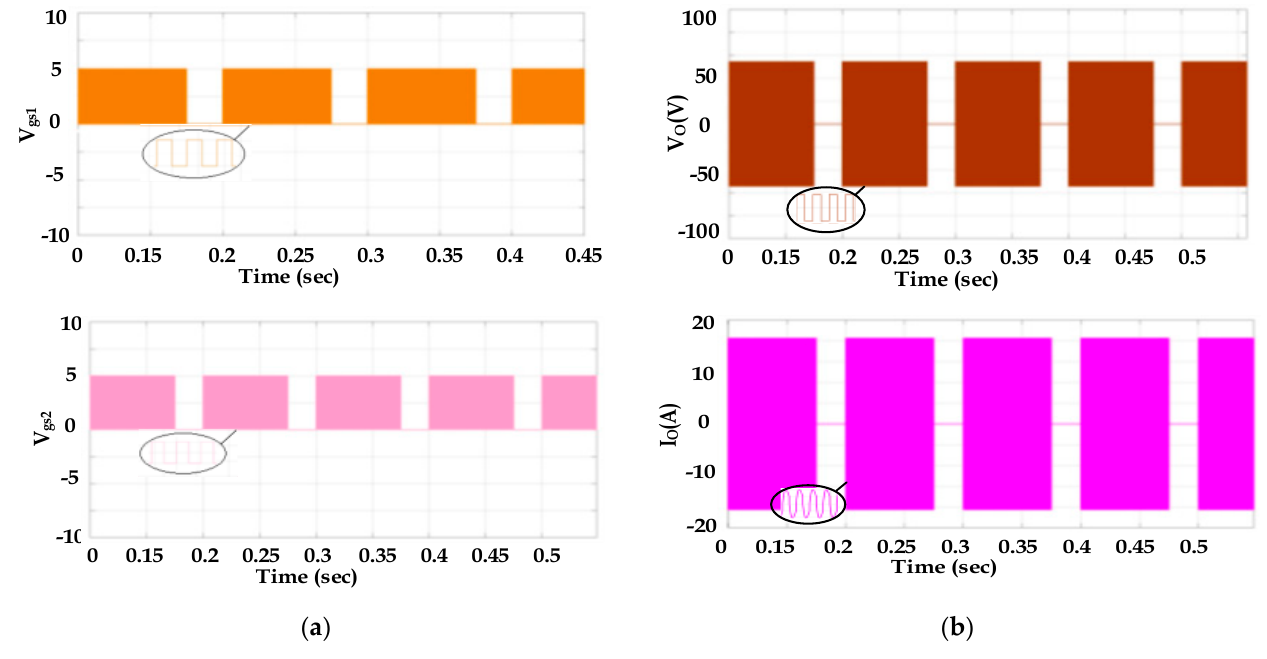
Figure 12. Simulation waveforms of Mode 2 with 75% PDM: ( a ) switching pulses and ( b ) output voltage and current.